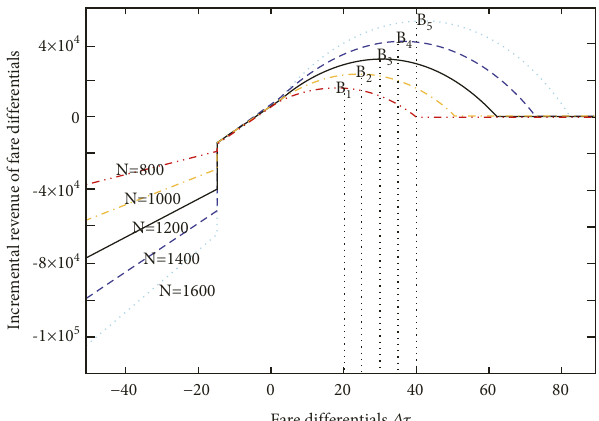
Figure 7: Effect of fare differentials on the total revenue of the metro